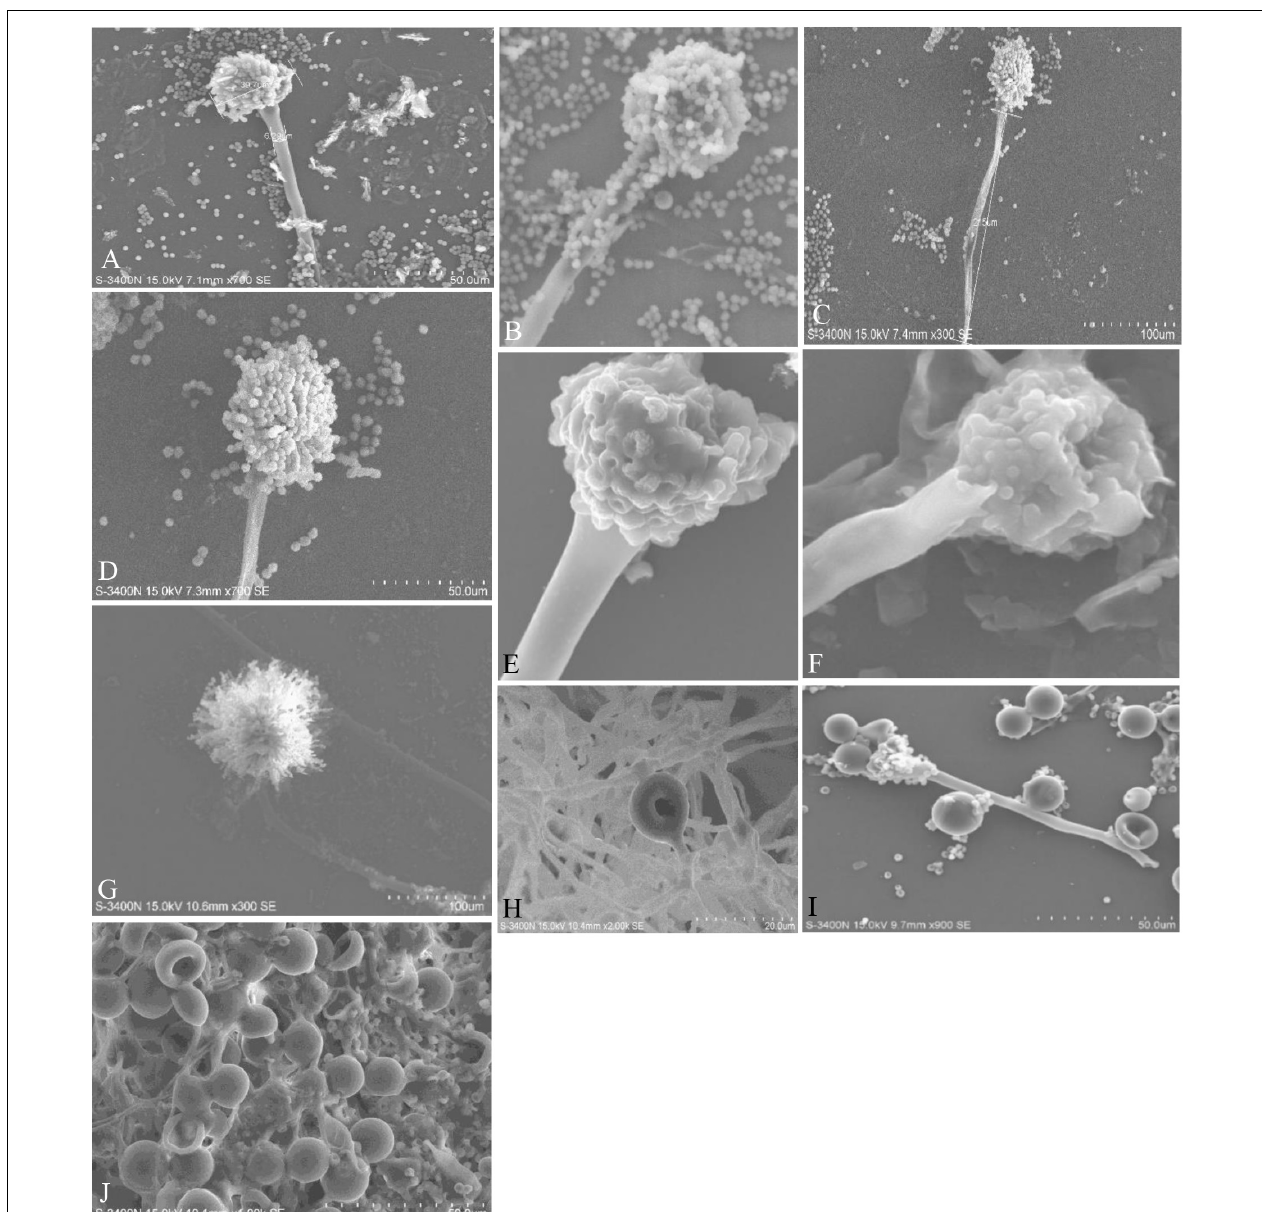
FIGURE 4 | Conidiophores, vesicles, metulae, phialides, conidia, and Hülle cells of the strains are shown in Scanning Electron Microscope (SEM) images. (A) Conidiophores of A. aureoterreus ; (B) conidiophores of A. terreus ; (C,D) conidial head with chains of conidia of A. tamarii ; (E) conidiophores of A. nidulans ; (F) conidiophores of A. latus ; (G) globose conidial heads, with metulae, phialides, chains of conidia and smooth conidiophores in A. awamori ; (H,I) mycelium and Hülle cell development and Hülle cells of A. nidulans (J) Hülle cells formation in E. quadrilineata.